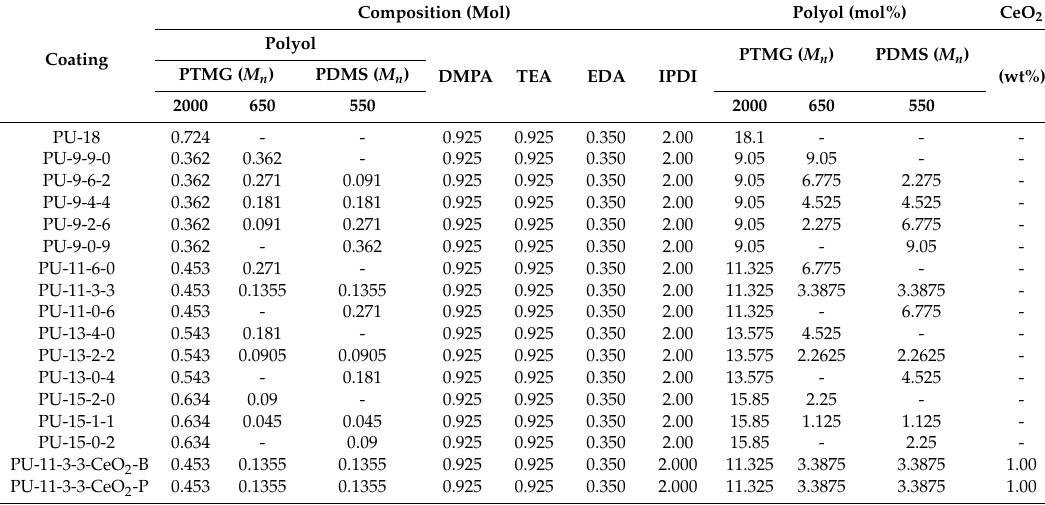
Table 1. Sample designation and composition of coatings. PDMS: polydimethyl siloxane, PTMG: poly(tetramethylene